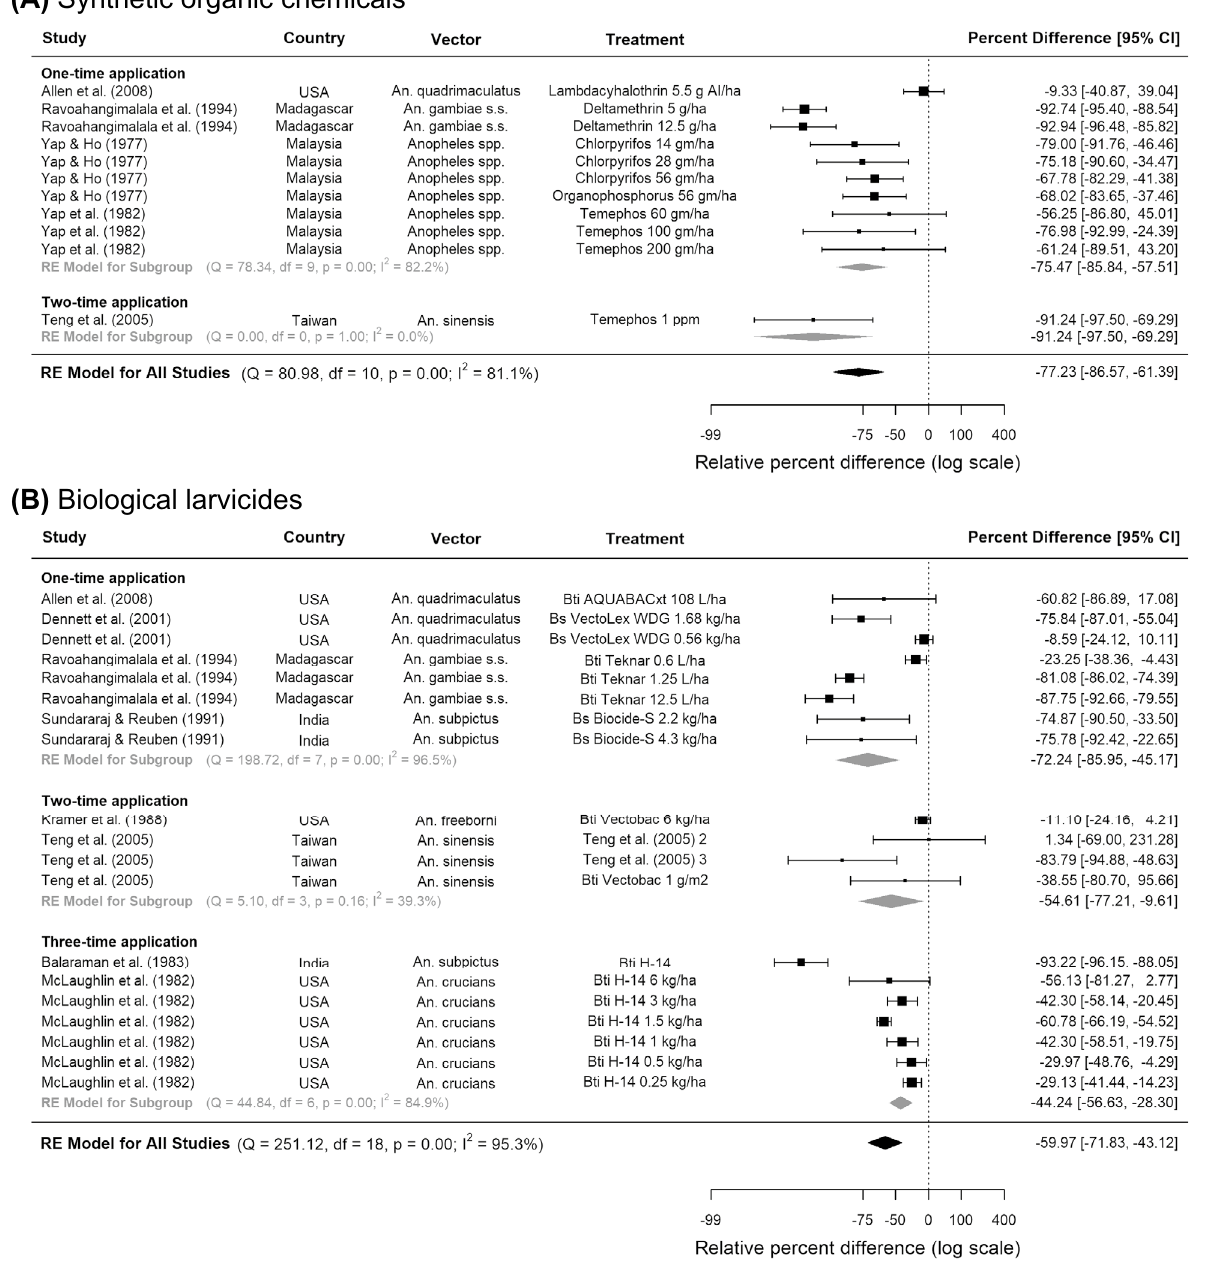
Figure 2. Pooled estimate of the effect of ( A ) synthetic organic chemicals and ( B ) biological larvicides on Anopheles larval densities in rice fields. Five controlled time series studies on ( A ) synthetic organic chemicals and eight controlled time series on ( B ) biological larvicides were included, conducted between years 1975 and 2004. Squares represent the relative effectiveness of individual studies, where square size represents the weight given to the study in the meta-analysis, with error bars representing 95% CIs; diamonds represent the pooled effects from random effects (RE) sub-group and